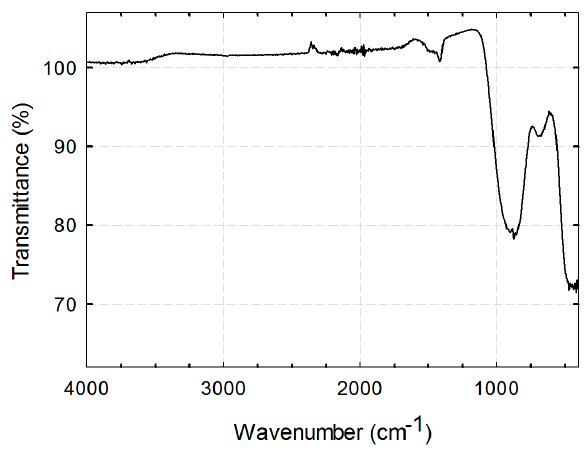
Figure 2. FT-IR spectrum of blast furnace slag.